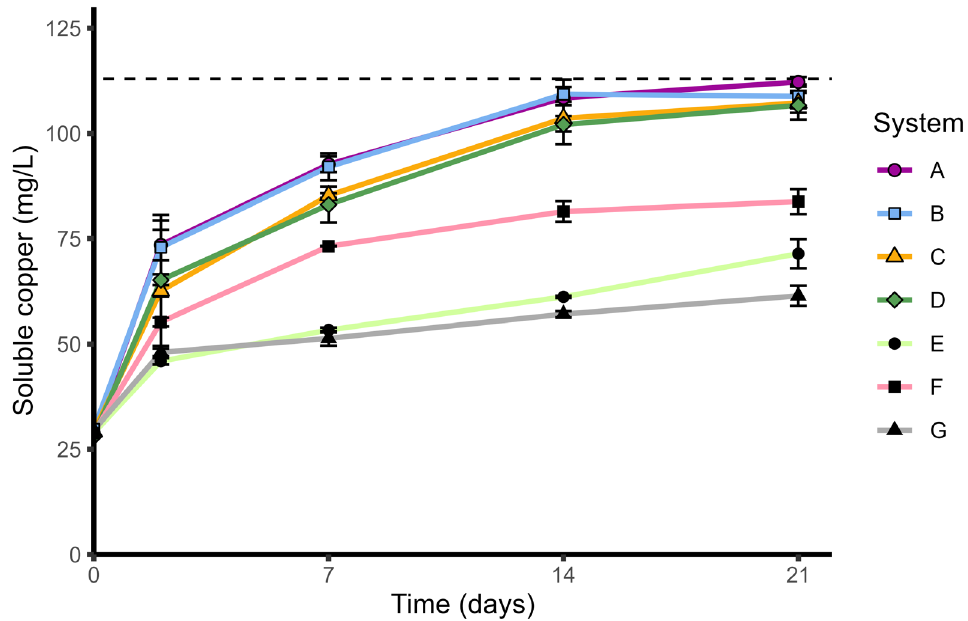
Figure 2. Kinetics of copper solubilization from Taca Taca ore by the native consortium incubated at 30 °C for 21 days. Dashed line represents the maximum copper recovery estimated. Bioleaching systems ( A )-( D ) were inoculated with the consortium. Three aqueous phases with initial pH adjusted to 2.0 were tested: distilled water ( A ), MAC medium ( B ), and local groundwater from Taca Taca ( D ). System ( C ) was performed in MAC medium with exogenous supplementation of ferrous iron and sulfur. Non-inoculated controls were performed in MAC medium ( E ) and with sulfur and ferrous iron supplementation ( F ). Sterile control ( G ) was performed in MAC medium using a sterilized mineral and paraformaldehyde.